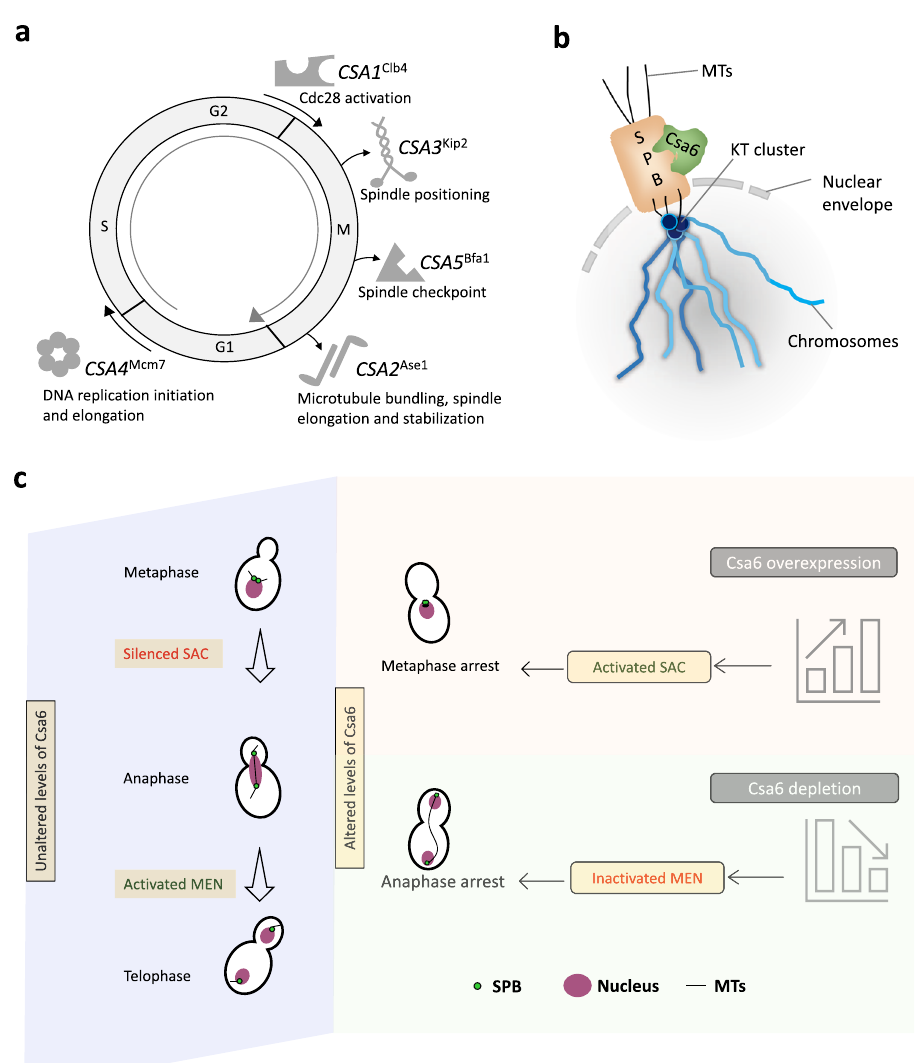
Fig. 8 Csa6 levels are fi ne-tuned at various stages of the cell cycle to ensure both mitotic progression and mitotic exit in C. albicans . a A diagram illustrating the functions of the identi fi ed CSA genes except for CSA6 in various phases and phase transitions of the cell cycle. b Schematic depicting the approximate position of Csa6 with respect to SPB and KT. In C. albicans , SPBs and clustered KTs remain in close proximity throughout the cell cycle, while Csa6 remains constitutively localized to the SPBs. c A model summarizing the effects of overexpression or depletion of Csa6 in C. albicans . A wild-type cell with unperturbed Csa6 levels progresses through the mitotic cell cycle. Overexpression of CSA6 alters the mitotic spindle dynamics, which might lead to improper KT-MT attachments, prompting SAC activation and G2/M arrest. In contrast, decreased levels of Csa6 inhibit the MEN signaling pathway, probably by affecting Tem1 recruitment to the SPBs, resulting in cell cycle arrest at the late anaphase/telophase